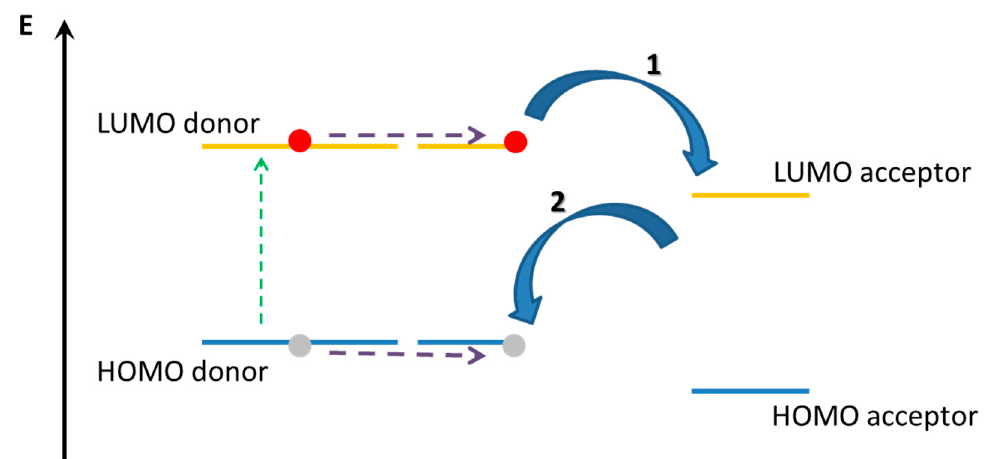
Figure 3. Energy levels of electron donor and electron acceptor during the electron-hole couple formation and separation.